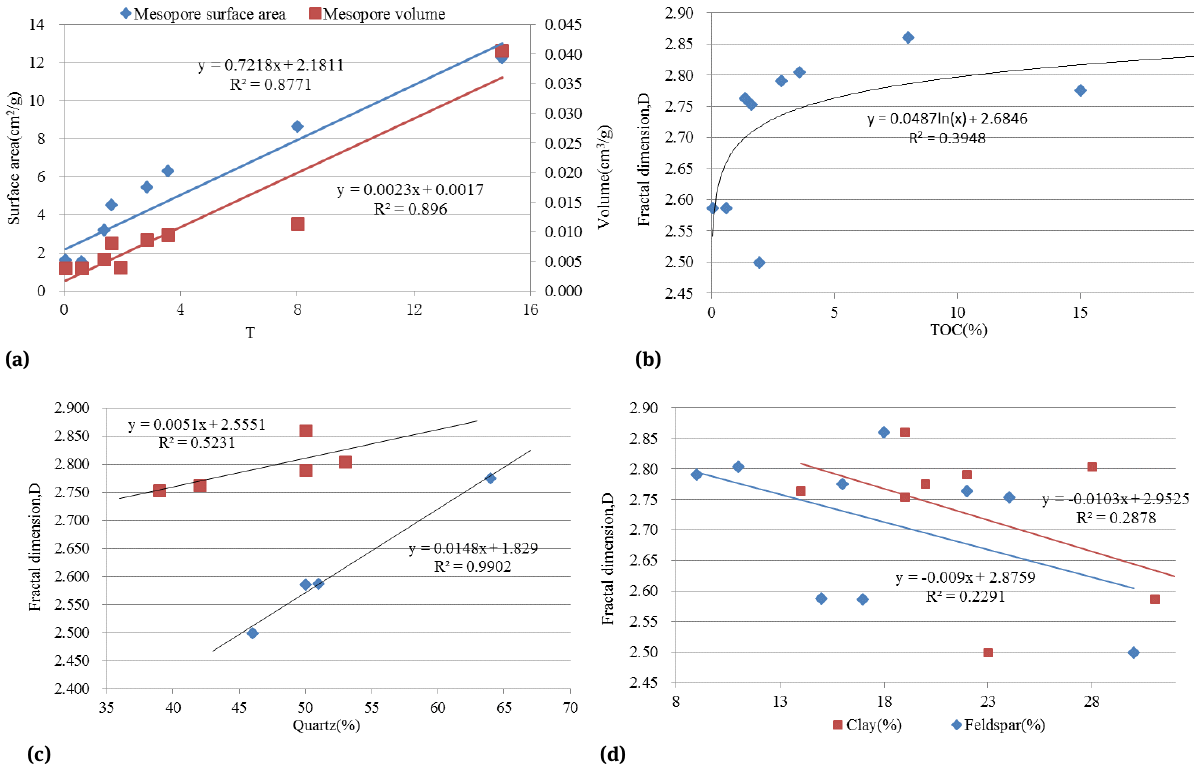
Figure 7: Correlation between FHH pore fractal dimension and TOC and mineral composition.